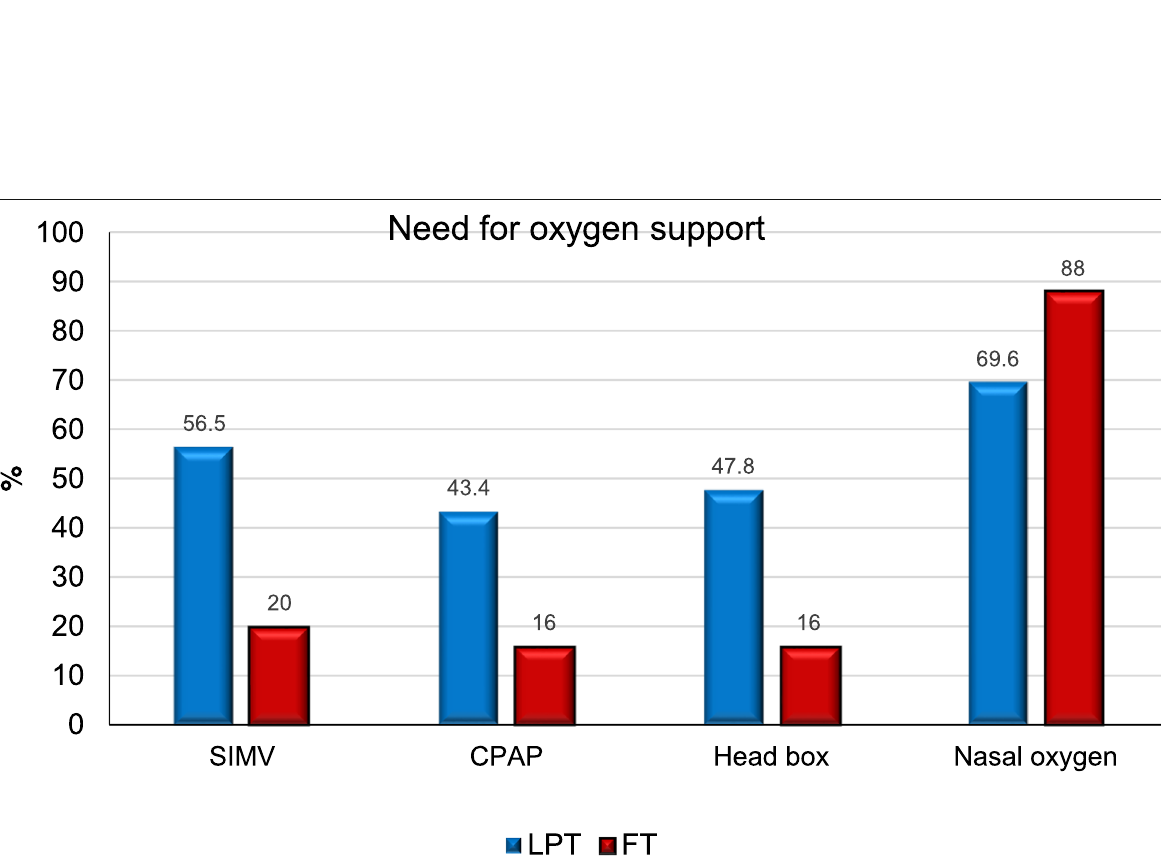
Fig. 2 Need for oxygen support in the studied groupsSIMV synchronized intermittent mandatory ventilation, CPAP continuous positive airway